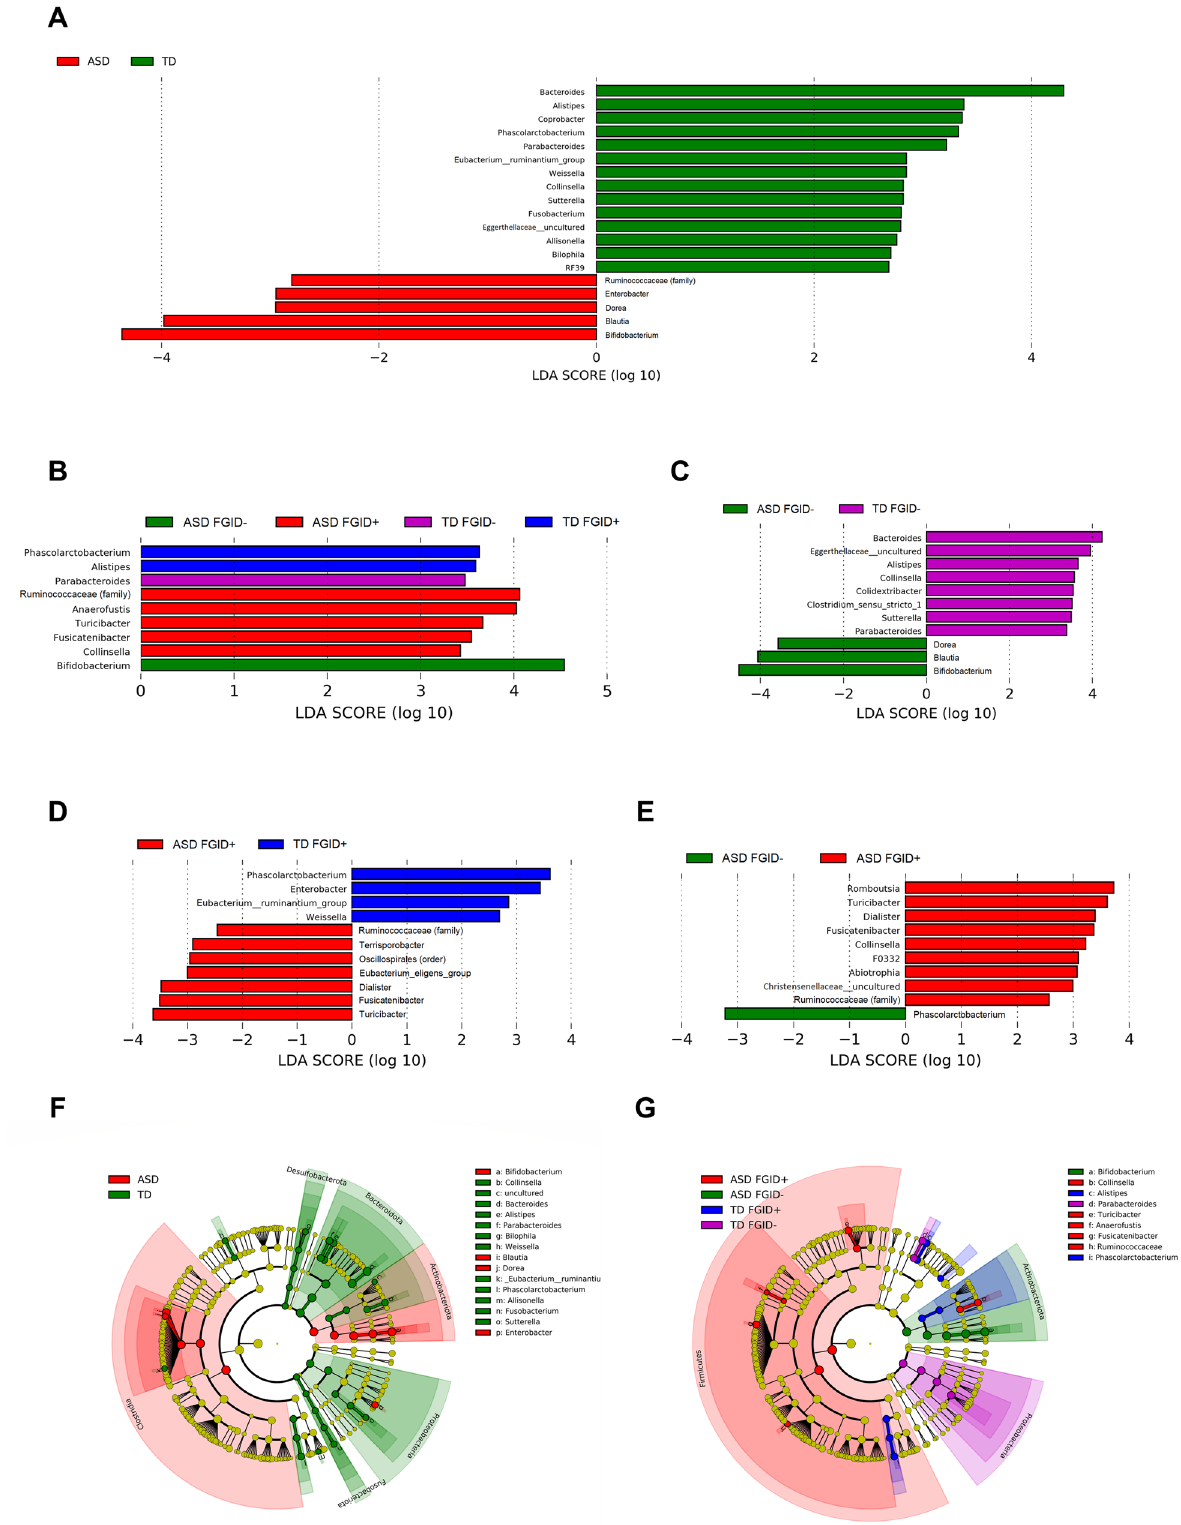
Figure 3. ( A – E ) Linear discriminant analysis (LDA) scores for the bacterial taxa that differentiate between ( A ) ASD vs. TD, ( B ) ASD FGID−, ASD FGID+, TD FGID−, and TD FGID+, ( C ) ASD FGID− vs. TD FGID−, D. ASD FGID+ vs/TD FGID+ and ( E ) ASD FGID− vs. ASD FGID+. The colours indicate the taxa enriched in the corresponding group of participants, with only the taxa of LDA score > 2.0 being shown. ( F , G ) Cladograms generated by Linear discriminant analysis Effect Size (LEfSe) indicating differences in the bacterial taxa between ( F ) ASD and TD and ( G ) ASD FGID−, ASD FGID+, TD FGID−, and TD